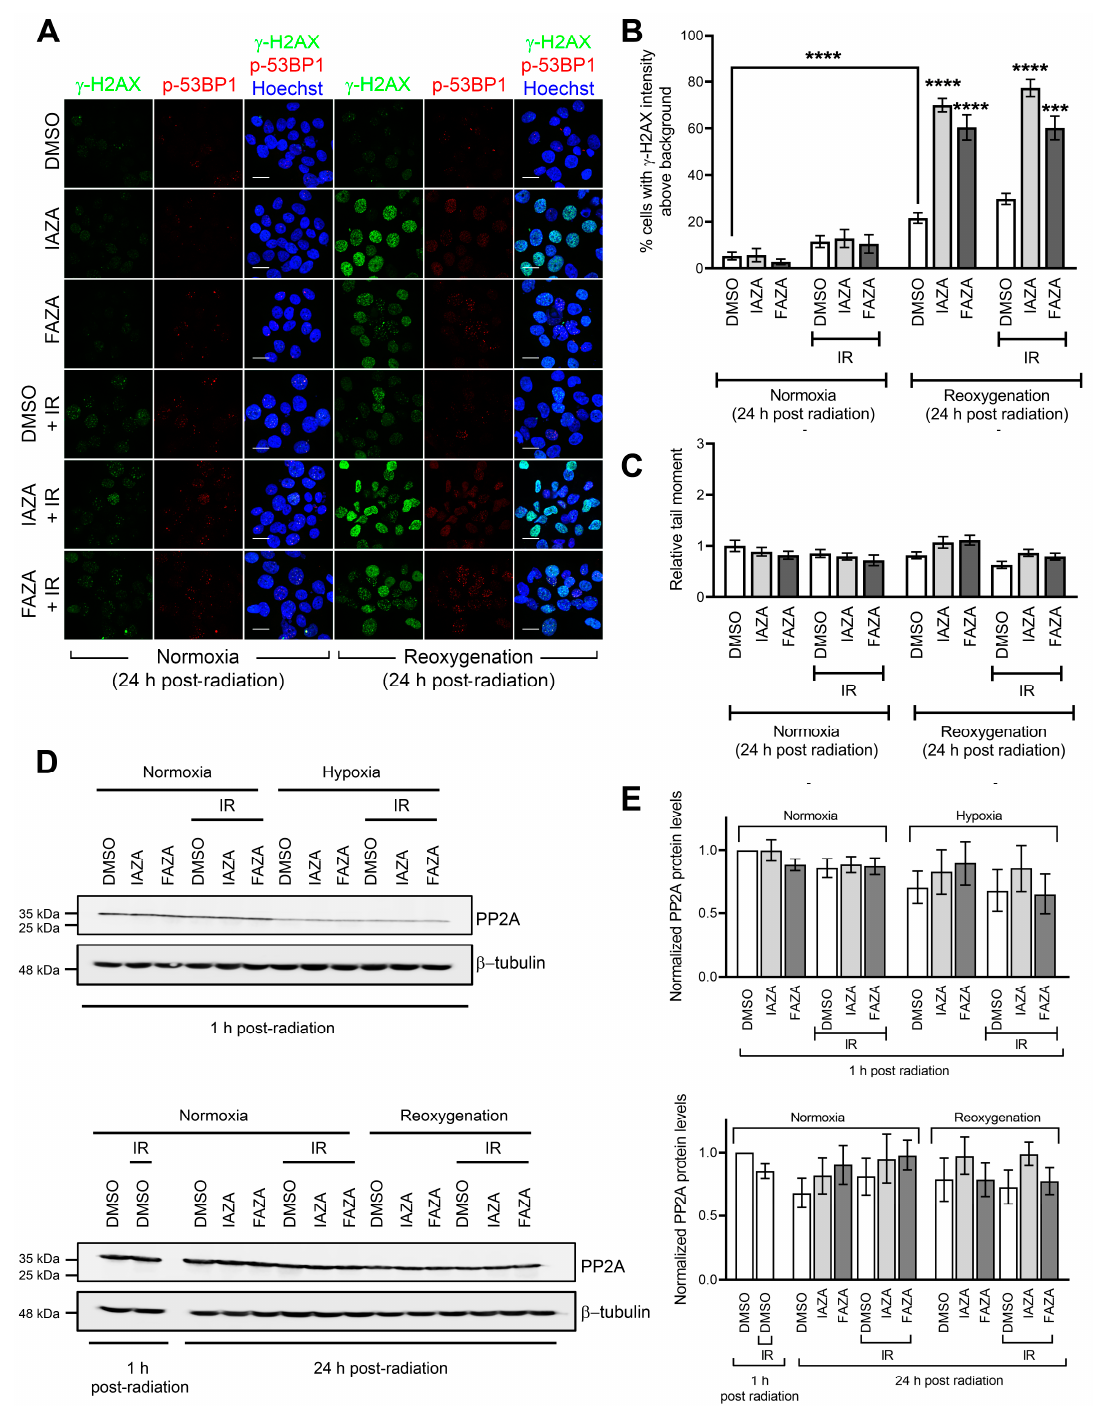
Figure 3. IAZA-/FAZA-treated hypoxic cells display high levels of γ -H2AX after reoxygenation, but not a corresponding increase in DNA damage. ( A ) Representative micrographs showing immunofluorescent staining of γ -H2AX and phopho-53BP1 in FaDu cells treated with vehicle control (DMSO) or drugs (IAZA or FAZA; 100 µM), with or without IR (5 Gy), under normoxia and hypoxia (<0.1% O 2 ), followed by a 24 h reoxygenation and recovery period; scale bar = 20 µm. ( B ) Drug-treated reoxygenated cells showed increased percentage of γ -H2AX-positive population, but no increase in comet tail moment ( C ). ( D ) No effects were seen on total PP2A protein levels in hypoxia/reoxygenation group when cells were treated with IAZA or FAZA. ( E ) Quantification of PP2A immunoblots. Data show mean ± S.E.M from three independent replicates.